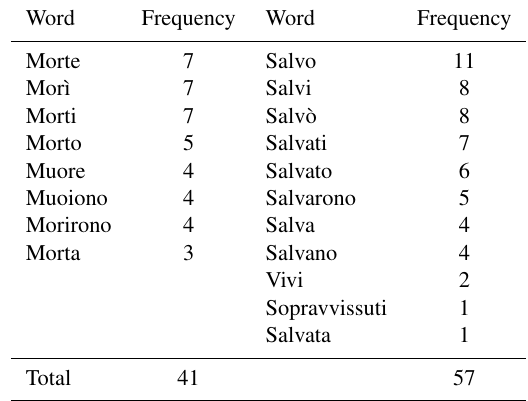
Table 2. Recurrences of terms related to death and to the verb to die (morte; moririe) and survival (including references to the words safe and alive and the verbs to save and to survive) in the written descriptions of all collected